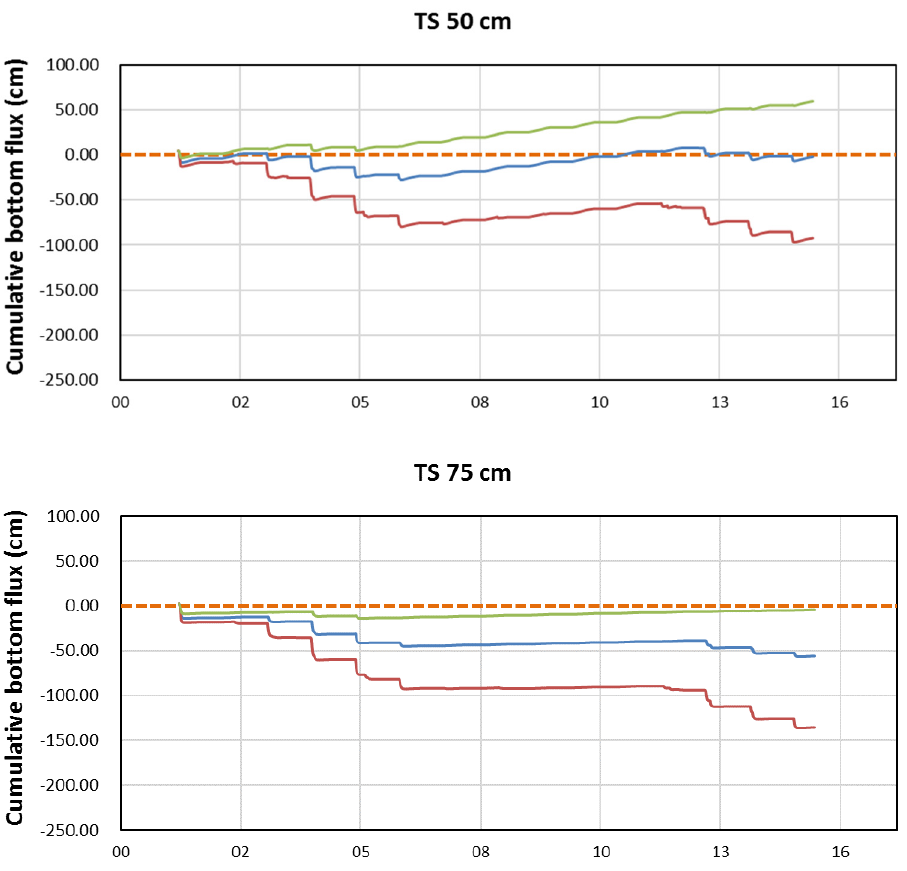
Figure 10. Final salt distribution in profiles under different capping strategies after 15 years of simulation (blue line, normal condition; red line, wet condition; green line, dry condition).